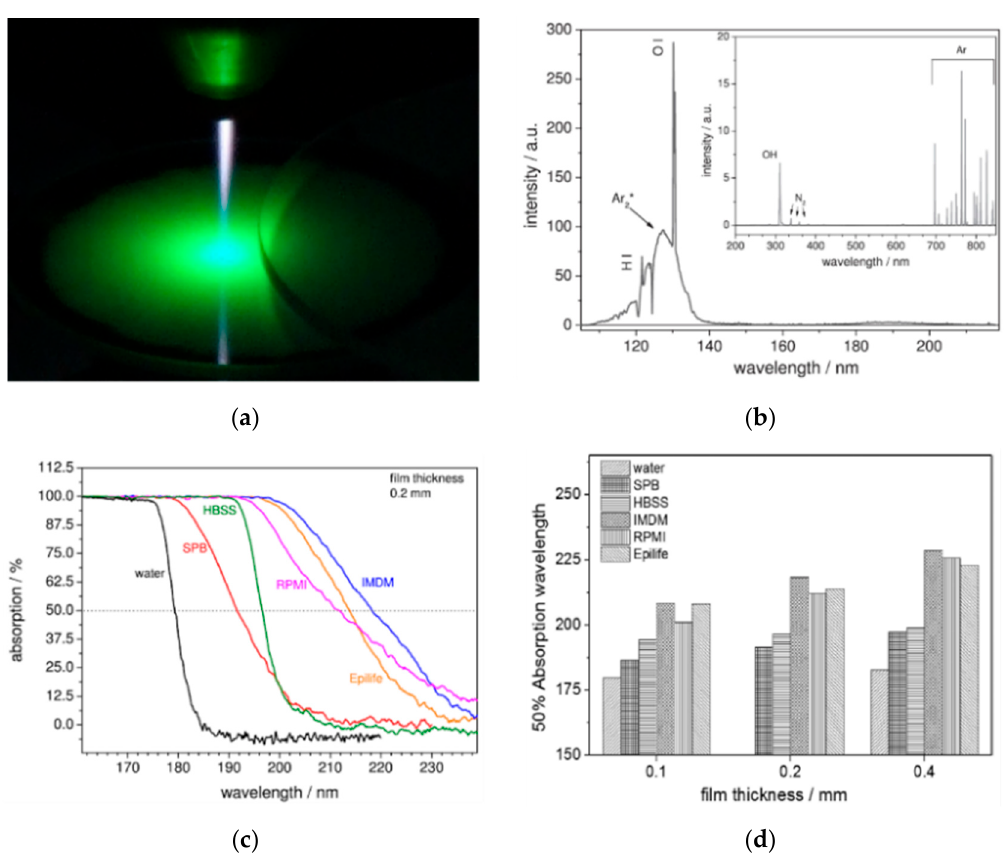
Figure 11. ( a ) VUV emission profile of an Ar plasma jet in a phosphorescing film used by Jablonowski et al., ( b ) VUV emission of an Ar discharge in ambient air, ( c ) VUV absorption of various test liquids at 0.2 mm sheath thickness and ( d ) wavelength at which 50% absorption of plasma-radiated VUV occurs of various test liquids as a function of their film thickness. Reprinted with permission from [208].